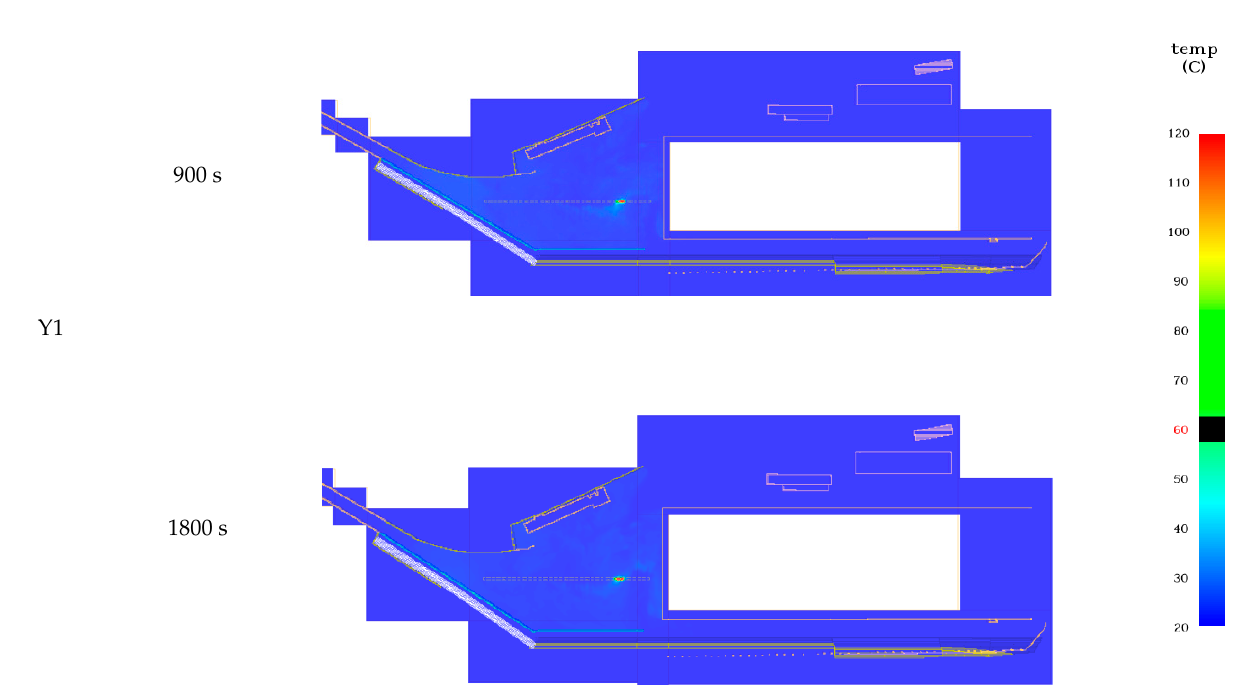
Figure 12. Throat area smoke spread. In this working condition, the fire danger advent time (ASET) at a distance of 4 m from the ground in the warehouse is greater than 1800 s, the fire danger advent time (ASET) at a distance of 6 m from the ground is 680 s, and the time required for the safe evacuation of personnel on the 3.5/3.6 m platform (RSET) is 413.5 s; ASET > RSET, the personnel in the warehouse can be evacuated safely. A train in the warehouse is used for fire, and the smoke is mainly discharged to the outside through the edge of the cover plate on the north side. The warehouse has a large area and a high net height, and the effect of storing and diluting smoke is better. In the case of smoke failure, a large amount of smoke settles in the ceiling. Although it does not affect the safe evacuation of personnel in the use warehouse, the safety margin of the time required for the safe evacuation of personnel is also short. Through the simulation analysis of the smoke and evacuation in the operation ware- house and the engineering garage, it can be concluded that when a fire occurs, the per- sonnel in the operation warehouse can be evacuated to the outdoor safe area within 505 s,